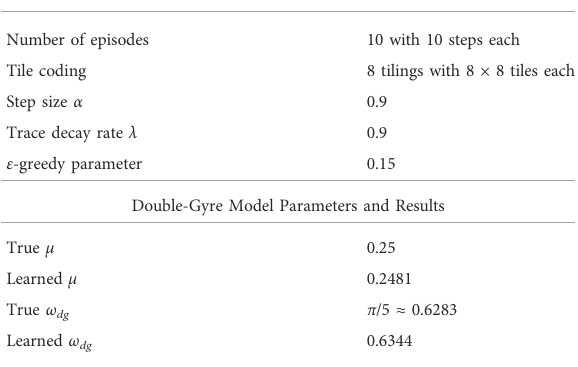
Frontiers in Robotics and